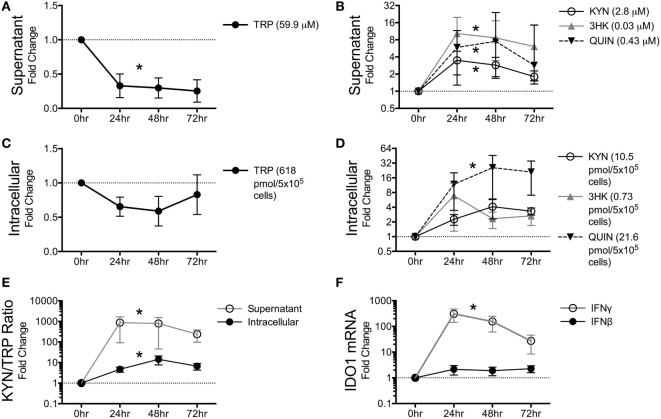
Macaque macrophages maintain intracellular tryptophan (TRP) levels at the expense of extracellular TRP during kynurenine pathway activation. Pigtailed macaque macrophages were stimulated with 25 ng/mL IFNγ. After 0, 24, 48, and 72 h, cell-free supernatants were harvested, and cell cultures were halved into aliquots for measurements of mRNA (IDO1) and metabolites (TRP, KYN, 3HK, and QUIN). To control for minor well-to-well variations in cell number that could affect metabolic turnover, intracellular and extracellular metabolites were normalized to intracellular and extracellular levels of the amino acid tyrosine, respectively. Data are represented as means ± SEM of the fold change over unstimulated controls at each time point. The average raw values of each metabolite in the unstimulated controls prior to fold change transformation are shown in parentheses on each graph (micromolar for supernatants; pmol/5 × 105 cells for intracellular lysates). The dotted lines represent the unstimulated controls at each time point. Results are from six independent experiments from different macaques, each with two cell culture technical replicates. (A) TRP levels in macrophage supernatants following IFNγ stimulation. (B) KYN, 3HK, and QUIN levels in macrophage supernatants following IFNγ stimulation. (C) Intracellular TRP from harvested cells following IFNγ stimulation. (D) Intracellular metabolites KYN, 3HK, and QUIN from harvested cells following IFNγ stimulation. (E) Intracellular and extracellular (supernatant) levels of KYN/TRP ratios, a surrogate for IDO1 enzyme activity, in macaque macrophages following IFNγ stimulation. (F) Intracellular IDO1 mRNA expression levels normalized to GAPDH mRNA in macrophage lysates following IFNγ or IFNβ stimulation as compared to unstimulated cells. Asterisks (*) represent analytes that were statistically different as a whole across all time points compared to controls as analyzed by the Friedman test for non-parametric, repeated measures data.